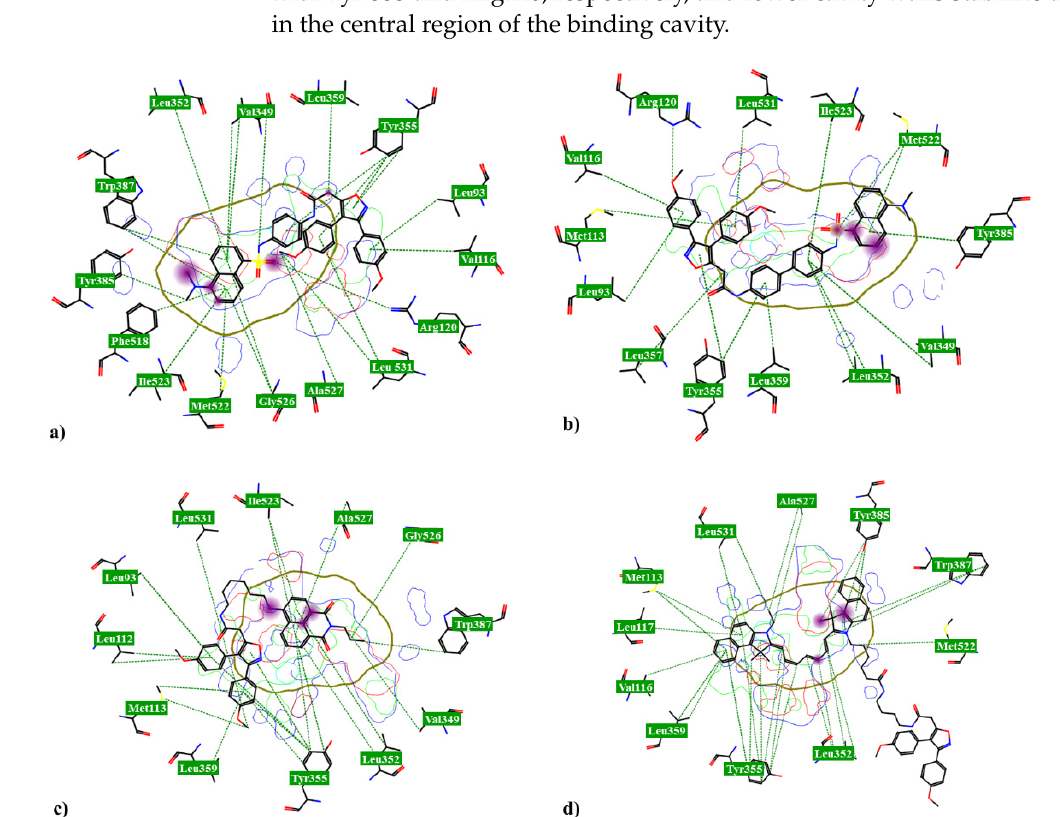
Figure 2. 2D FLAP binding poses of 3b ( a ), 3c ( b ), 17a ( c ) and 23 ( d ) inside the substrate-binding site of h COX-1 (PDB ID:6Y3C). Residues located in the h COX-1 binding site are highlighted in stick-mode: the most important amino acids are shown together with their respective numbers. Purple regions indicate strong interactions. Colored lines represent the area of hydrogen-bonding donor interactions (red), hydrogen-bonding acceptor interactions (blue), and hydrophobic interactions (green).